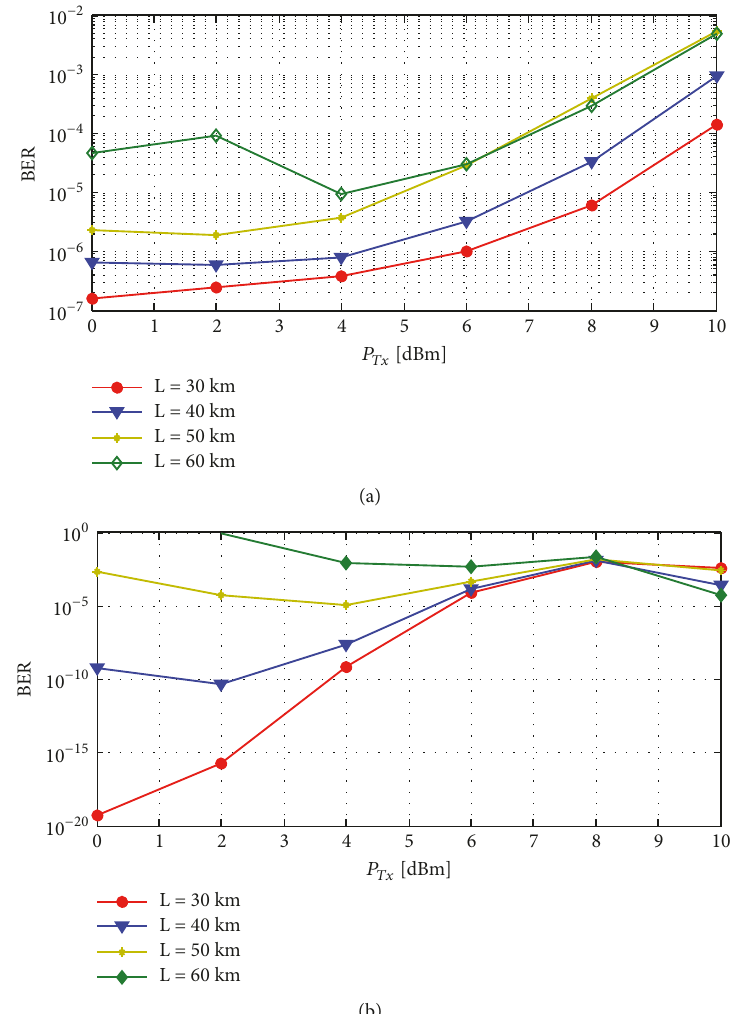
Figure 16: BER curves versus optical launch power for different fiber length values ( (cid:2) 𝛼 PDL = 0.03 dB, (cid:2) 𝜗 = 5 ∘ , and f BR = 10 Gbit / s ) at (a) 𝜆 ≅ 1310 nm; (b) 𝜆 ≅ 1550